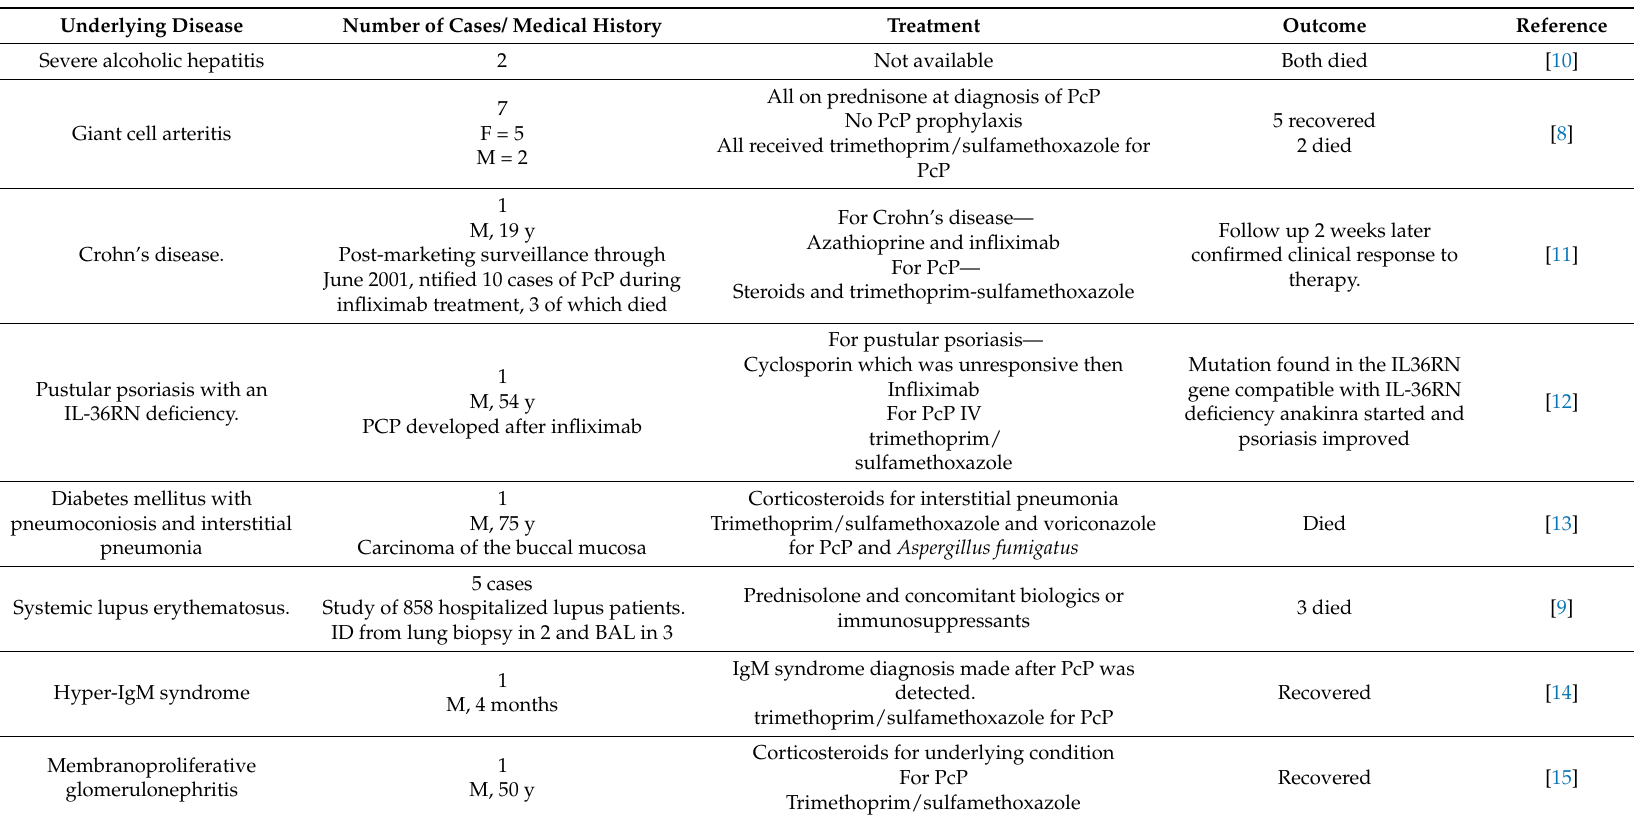
Table 1. A selection of Pneumocystis Pneumonia cases involving patients with less typical underlying